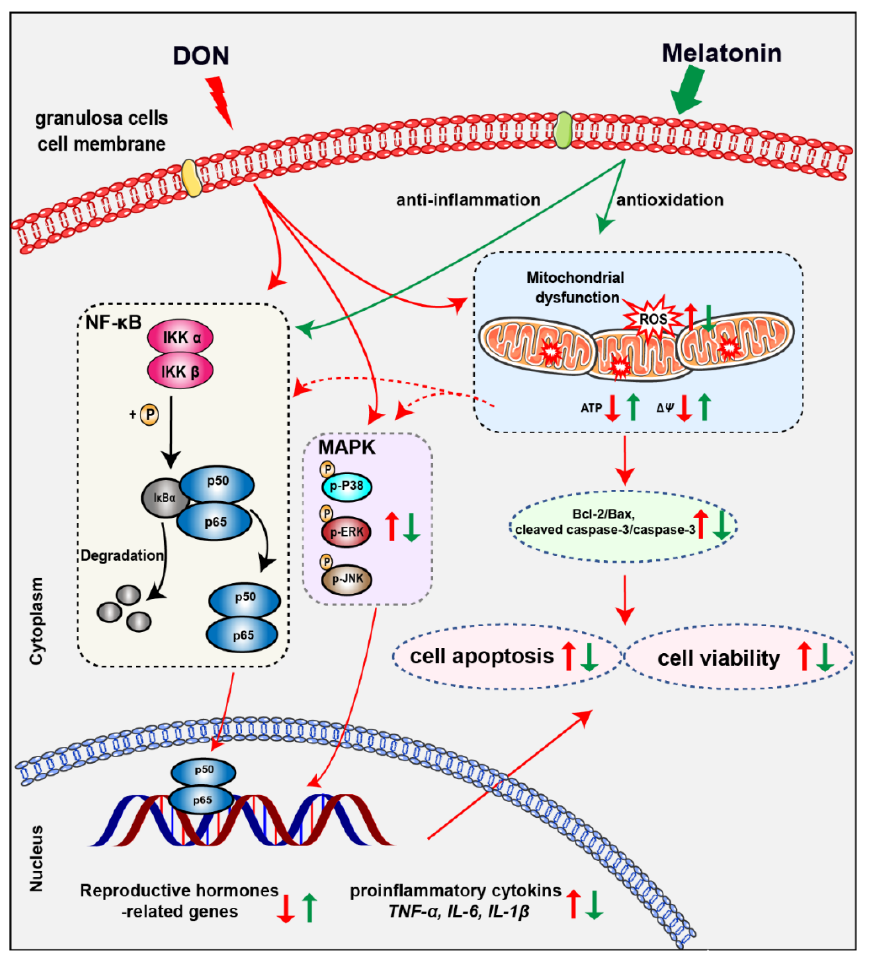
Figure 7. Diagram of DON exposure and melatonin administration to murine ovary granulosa cells.